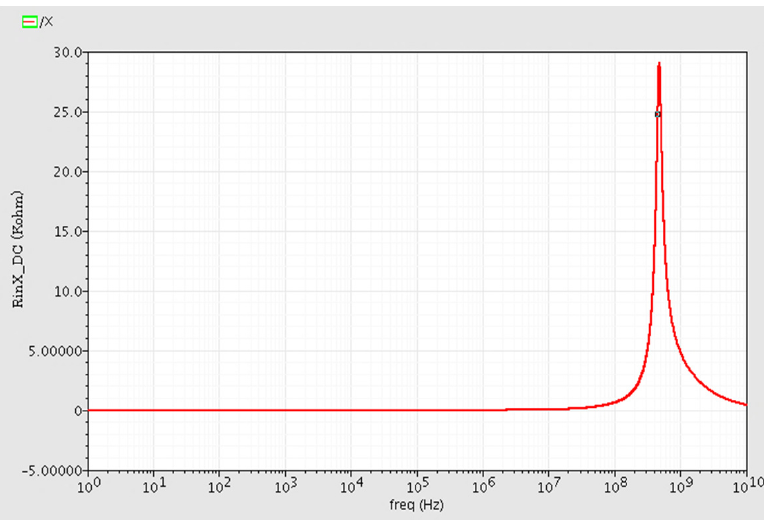
Figure 5. The X terminal input resistance R X versus frequency changes. It is measured less than 20 ohm in low frequency and DC operation regions.